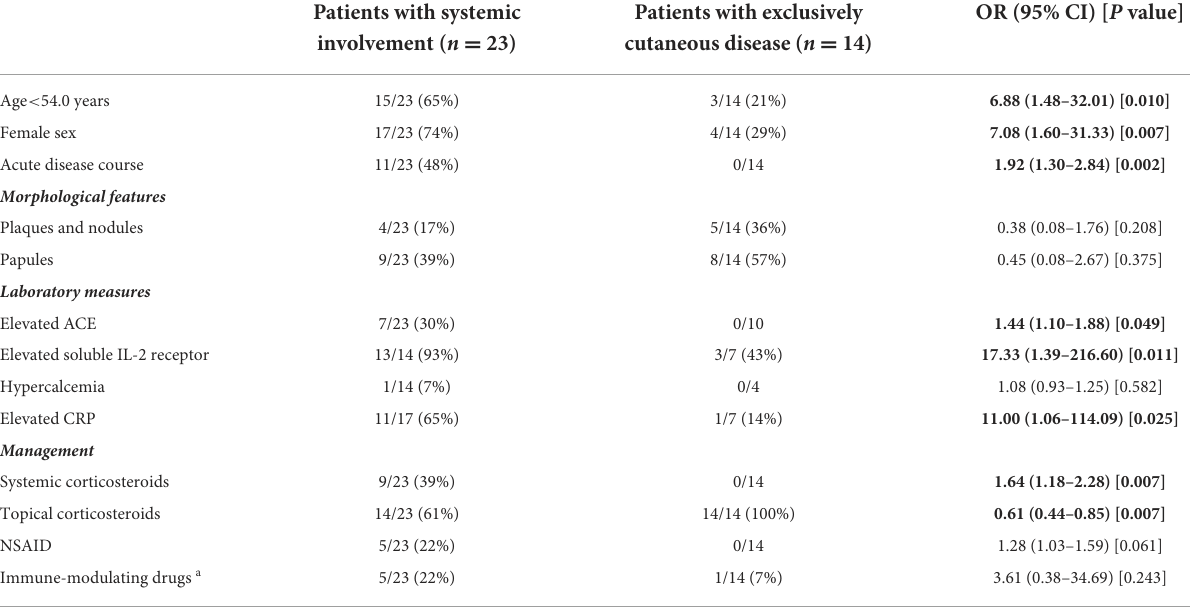
TABLE 2 Predictors of systemic involvement among patients with cutaneous sarcoidosis. Patients with systemic Patients with